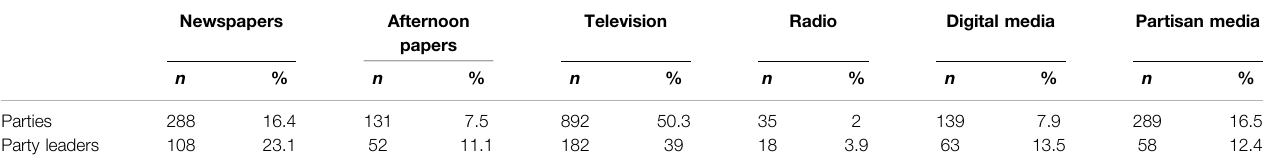
TABLE 5 | Types of traditional media shared in the social media posts of parties and